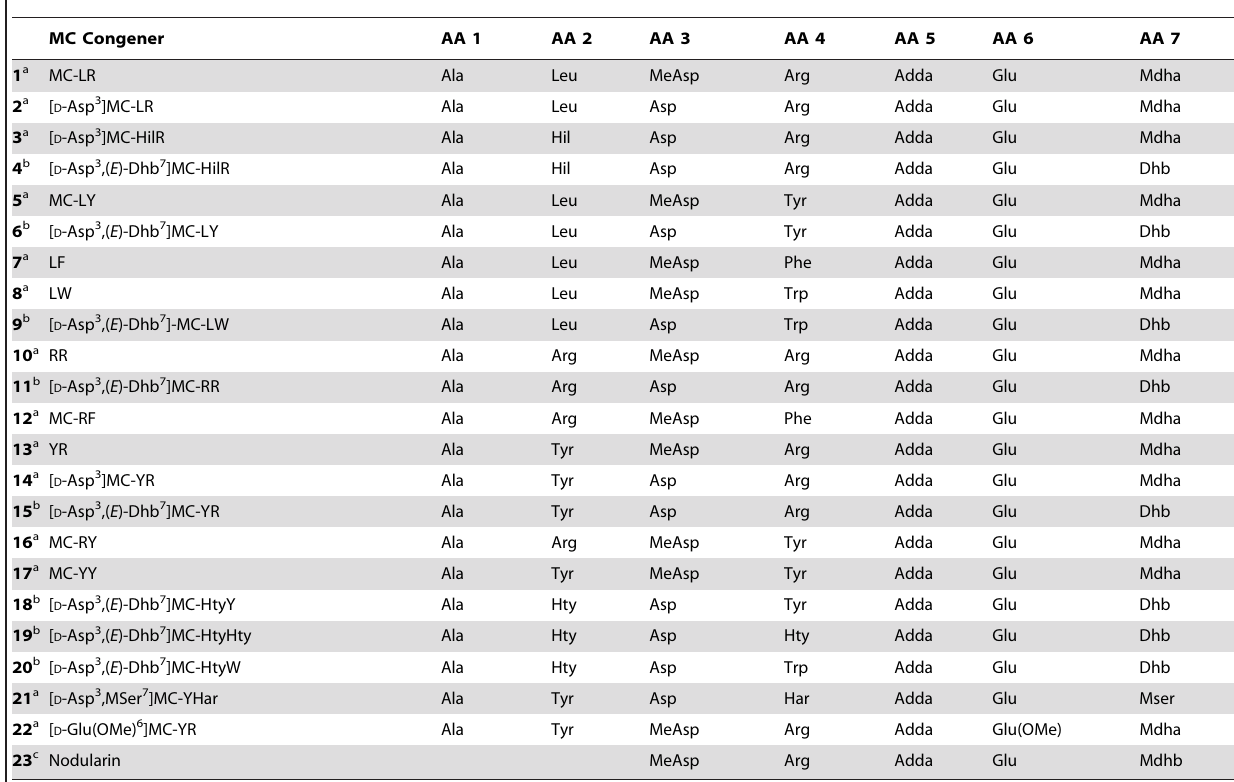
Table 1. Structures of the tested MC congeners originating from a Microcystis aeruginosa , b Planktothrix rubescens , and c Nodularia